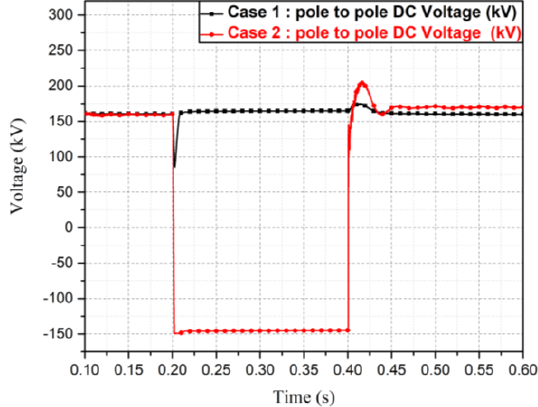
Figure 13. The waveform of the DC line current and voltage across the CB in the transient state: ( a ) the DC line current; ( b ) the voltage across the CB. Figure 14. The waveform of pole-to-pole DC voltage in the case of pole-to-pole Figure 14. The waveform of pole-to-pole DC voltage in the case of pole-to-pole fault.